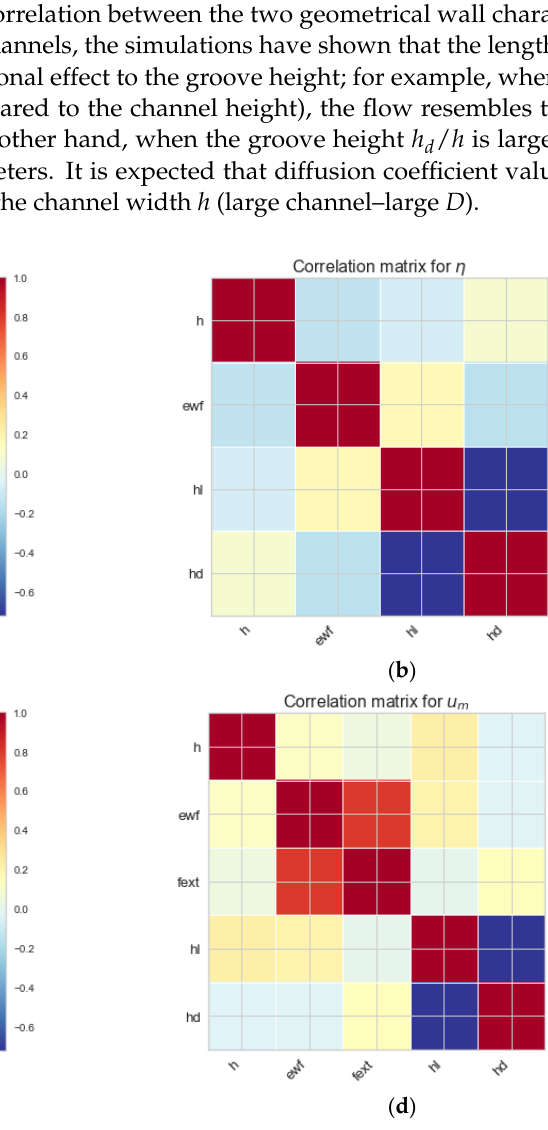
Figure 4. Correlation matrices for dataset parameters: ( a ) diffusion coefficient D , ( b ) shear viscosity η , ( c ) thermal conductivity k and ( d ) average channel velocity u m . Table 3. Variation inflation factors (VIFs).